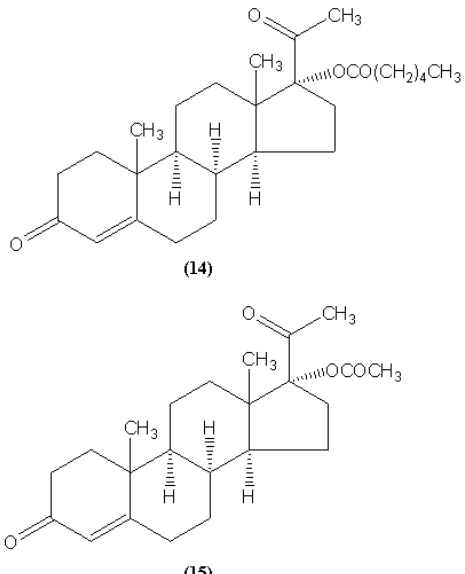
Figure 6. 17–hydroxyprogesterone caproate (17–OHPC, 14 ) and medroxyprogesterone acetate (MPA, 15 ).